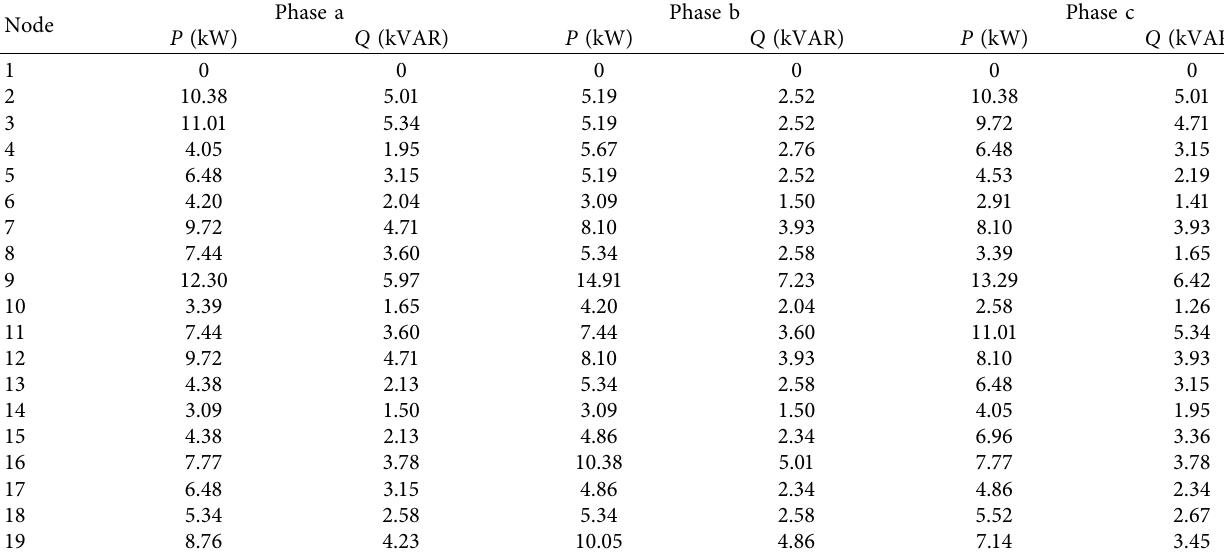
Table 3: Loads of 19-bus network.